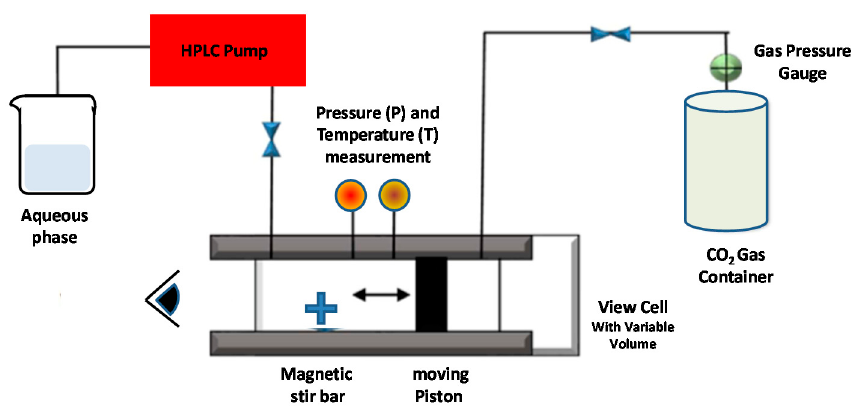
Figure 9. Schematic representation of the apparatus used in the supercritical reverse-phase evaporation method [109].